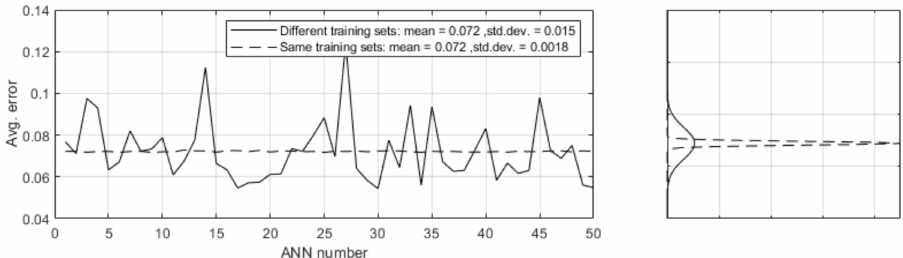
Figure 5. Neural network error dispersion comparison between using same versus different training data.